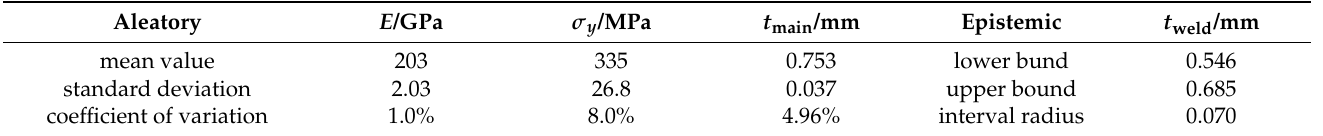
Table 6. Aleatory and epistemic uncertainty model inputs.